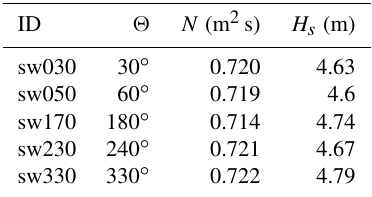
Table 1. Initial parameters of the simulation series.